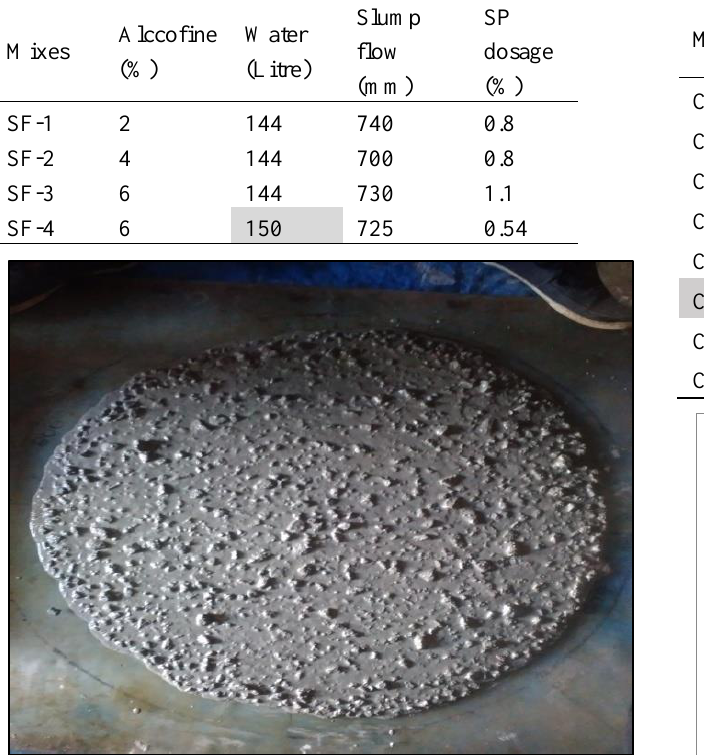
Fig. 11. Flow of Silica fume mix